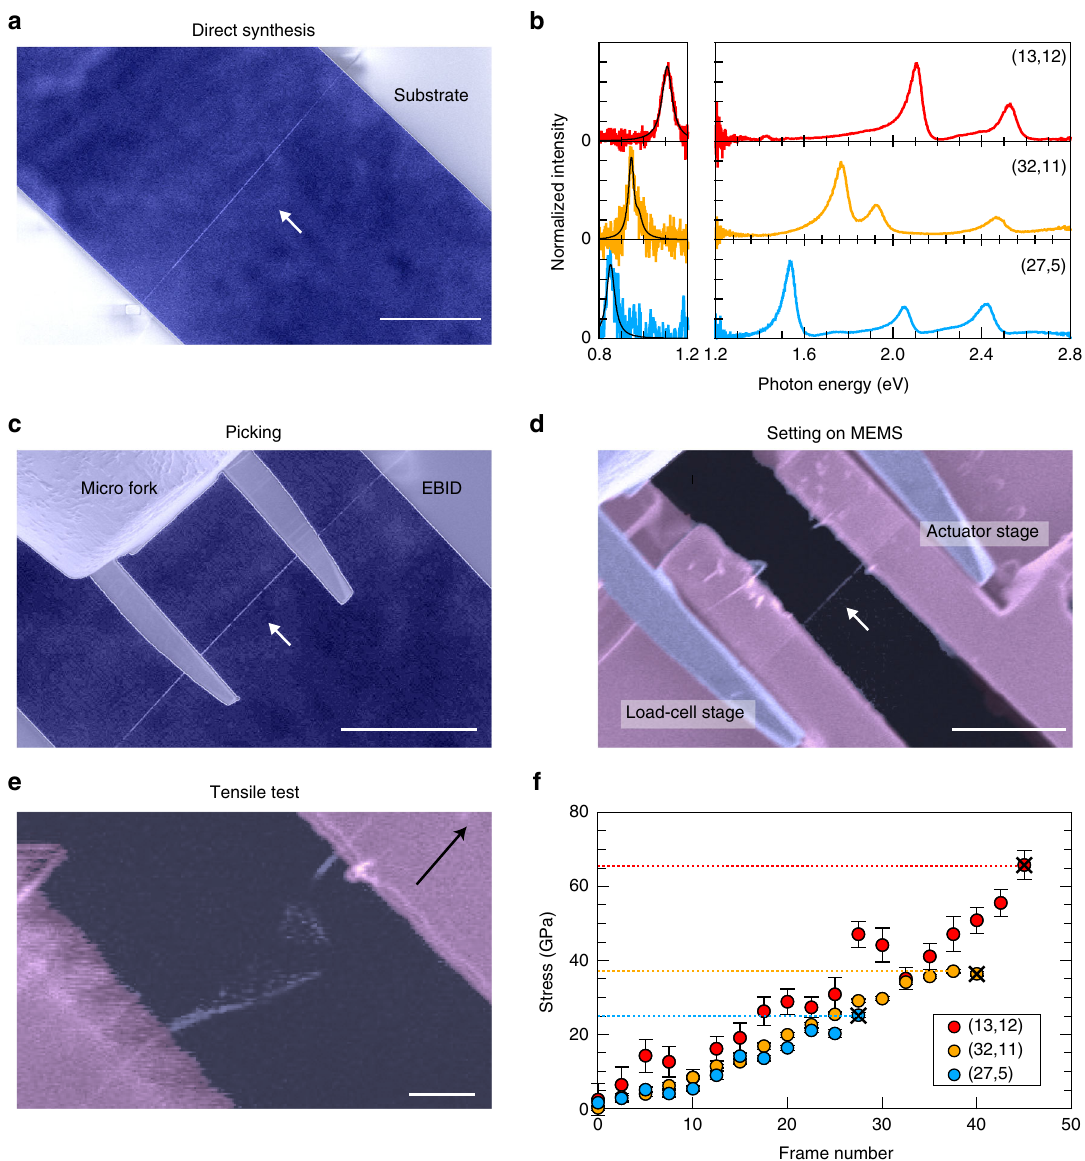
Fig. 2 Experimental procedures for the tensile strength measurement. a Individual nanotube directly synthesized over an open slit. Scale bar, 10 µ m. b Broadband Rayleigh scattering spectra of three nanotube species used for the chiral structure assignment. Different photodetectors were used for the 0.8 – 1.2 eV and 1.2 – 2.8 eV ranges. The black curves show the fi tting results (see Methods). c Pick-up operation of an individual nanotube using a micro fork. Scale bar, 10 µ m. d Setting a nanotube on the microelectromechanical system (MEMS) device. Scale bar, 5 µ m. The nanotube is fi xed to either the micro fork, substrate, or MEMS device via the electron-beam-induced deposition (EBID) method. e Image taken at the moment of nanotube fracture during the tensile test. The black arrow indicates the direction of actuator stage movement. Scale bar, 1 µ m. f Stress as a function of image frame number for three nanotube species. The dashed lines indicate the tensile strengths. The color, contrast, and brightness of each image are tailored for clarity. The error bars indicate the 95% con fi dence